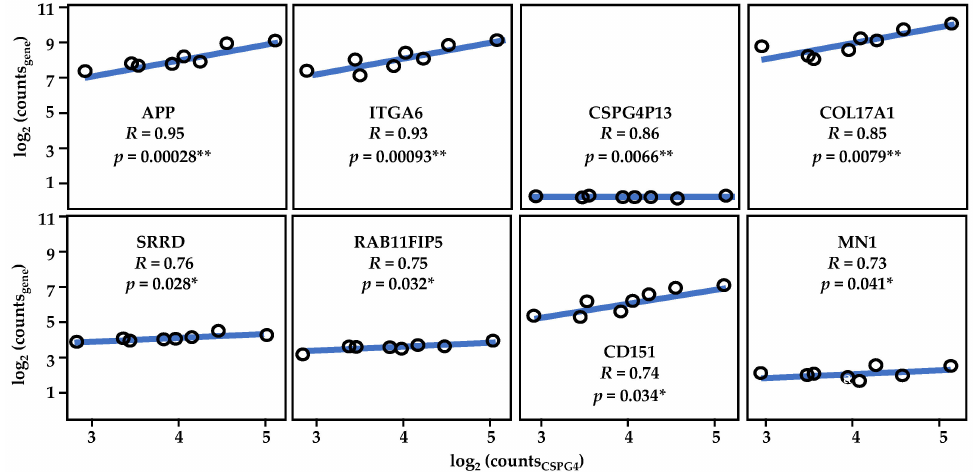
Figure 6. Results of re-analysis of RDEB-SCCs transcriptome data. Shown, the strong correlation between CSPG4 and ITGA6, as well as that of CSPG4 and COL17A1. CSPG413 is a pseudogene which is co-expressed with CSPG4 (by Pearson Correlation, * p < 0.05, ** p < 0.01; α = 0.05). Figure derived from re-analysis of publicly available published data: GSE130925 [43] and GSE130925 [145]. See also Supplementary Table